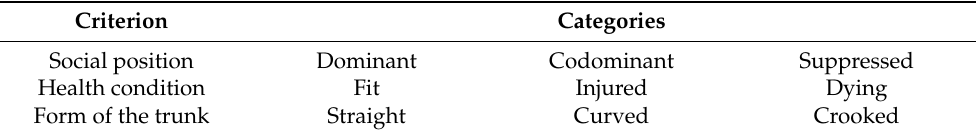
Table 1. Quality criteria for the trunks inside the